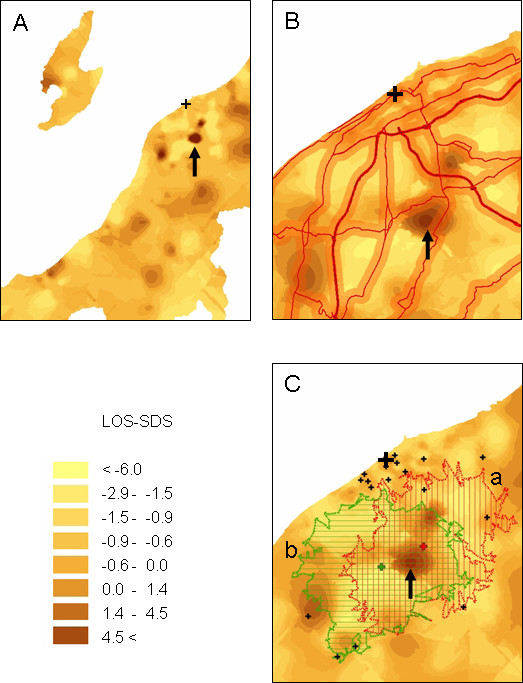
Clusters of the patients with high LOSSDS. (A) Contour map of LOSSDS of the patients was produced by interpolation using the ordinary Kringing method. Dark contours represent the clustering of patients with high LOSSDS. Cross and arrow represent the locations of Niigata University Hospital and a focus of clustering of patients with high LOSSDS, respectively. (B) The arterial roads around the focus shown in (A) and their 1,000 meter buffer are shown. (C) Hospitals around the focus shown in (A). The focus is located in an area 30 min by car from the two hospitals a and b. The locations of the two hospitals and their 30-min areas are shown as bold crosses and hatch patterns. The small crosses represent other hospitals.